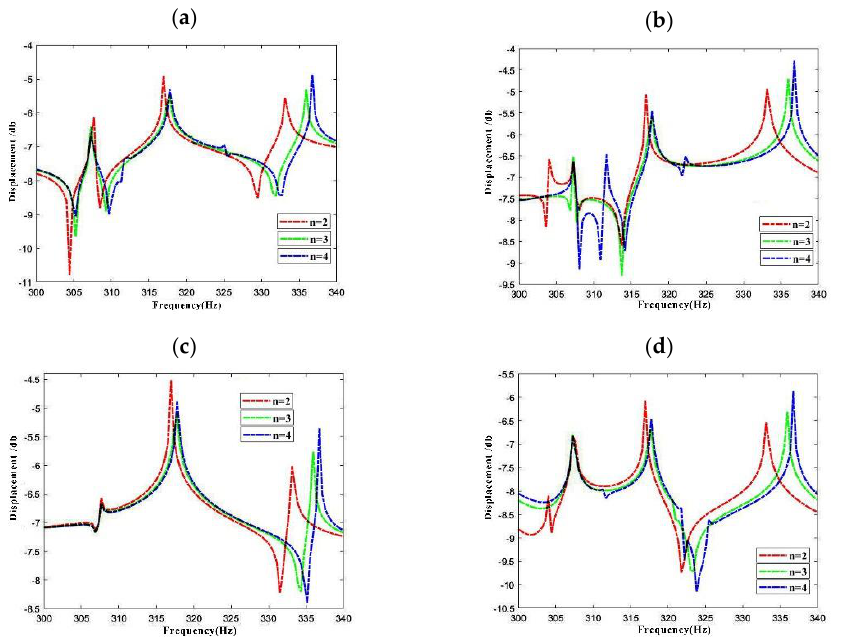
Figure 9. Variation of response vibration frequency for LCDCSS with various material layer scheming. ( a ) Point 1#; ( b ) Point 2#; ( c ) Point 3#; ( d ) Point 4#.